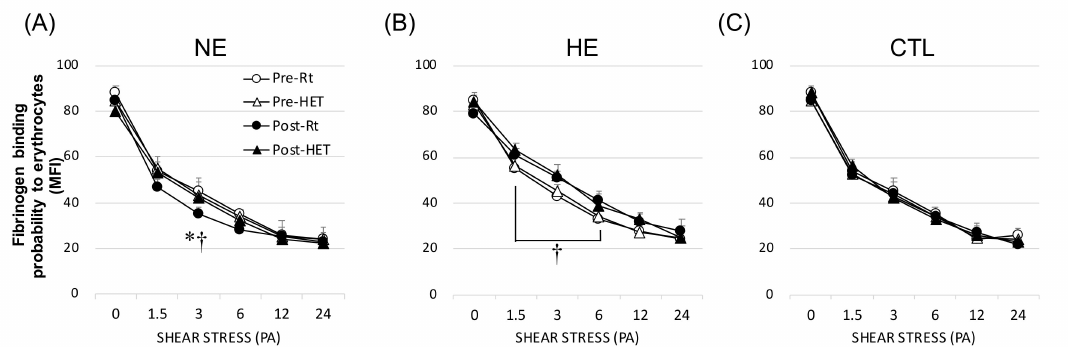
Figure 3. Measurement of fibrinogen binding probability to erythrocytes: ( A ) normoxia training group, ( B ) hypoxia training group, and ( C ) control group. Pre (white), pretraining; Post (black), post-training; Rt (circles), at rest; HET (triangles), immediately after HET; MFI, median fluorescence intensity. * p < 0.05, Rt vs. HET; † p < 0.05, pre vs. post. Values are the mean ± SEM.